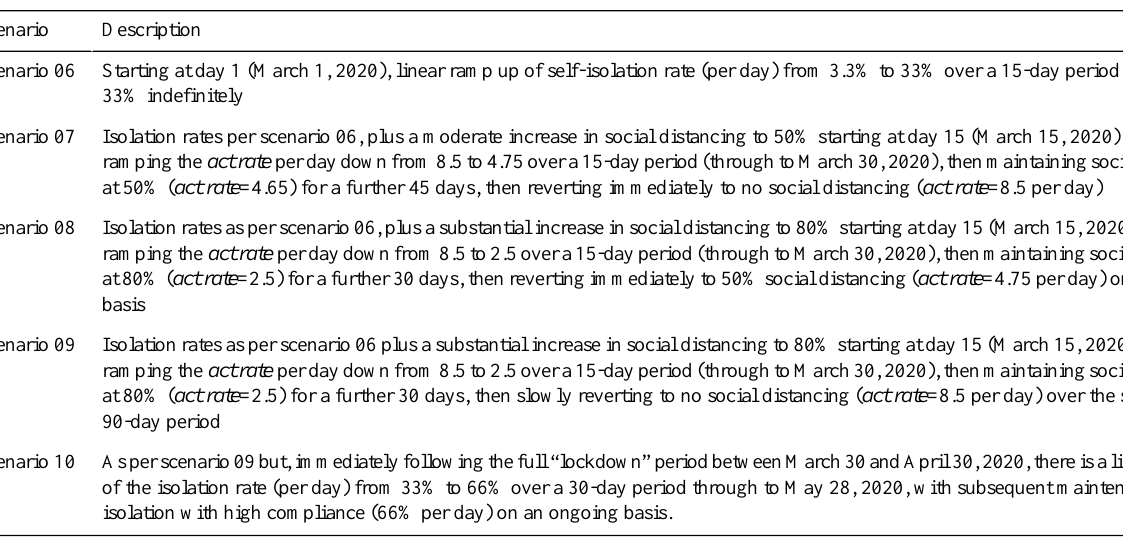
Table 4. Scenarios modeled for April 30,